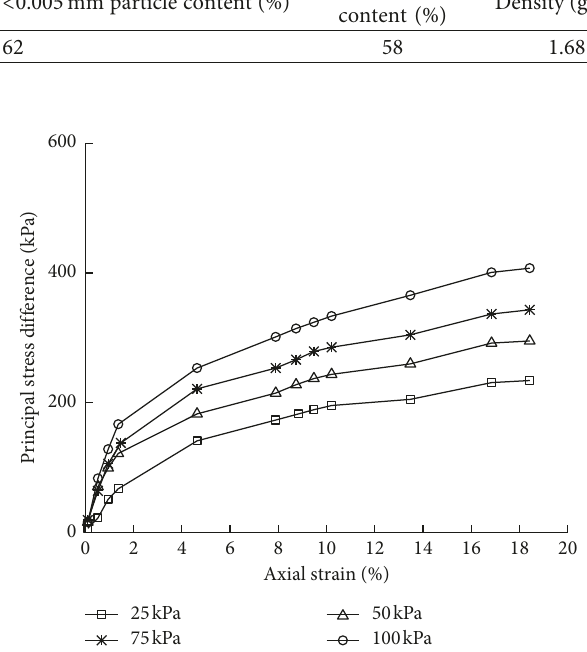
Figure 1: Stress-strain curve of 96% compaction.